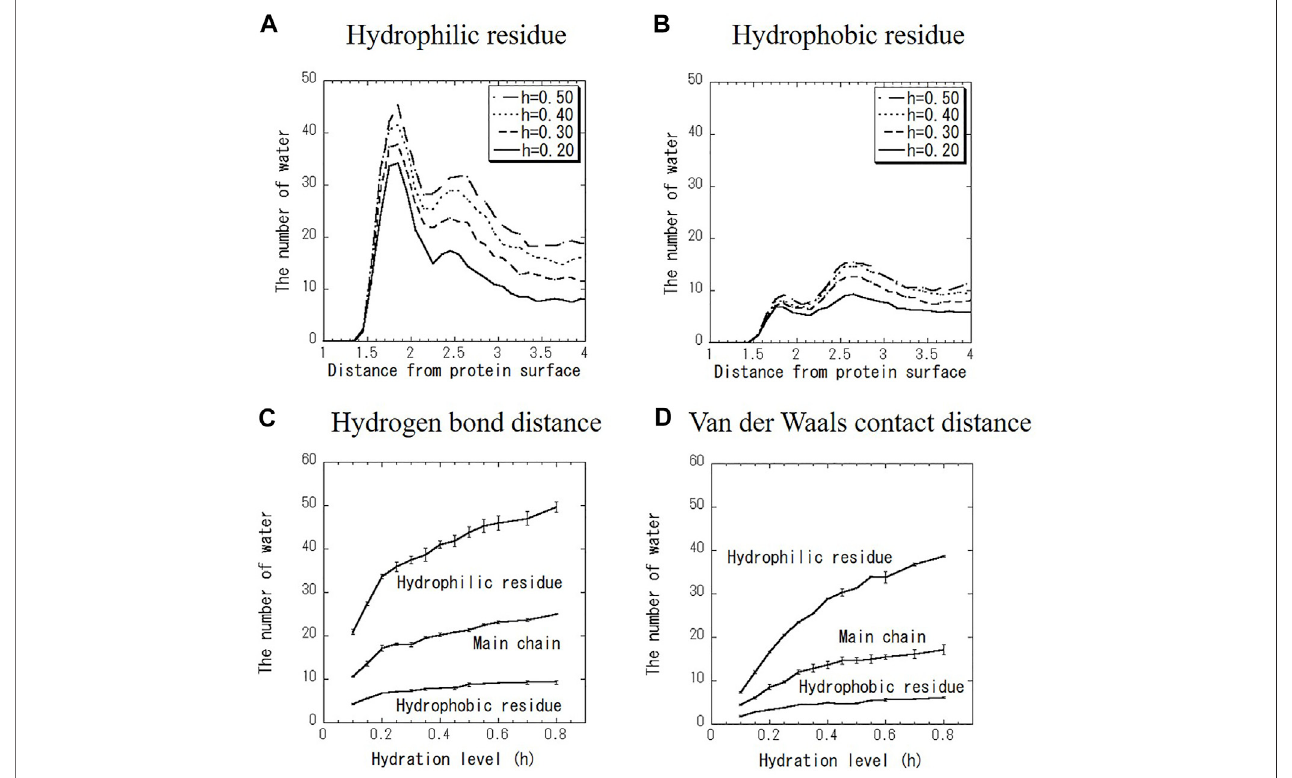
FIGURE 3 | Distribution of the number of water molecules on (A) hydrophilic residue and (B) hydrophobic residue. Hydration level dependence of the number of water molecules at (C) hydrogen bond distance (1.8 Å) and (D) VDW contact distance (2.5 Å) for hydrophilic and hydrophobic residues and the main chain.